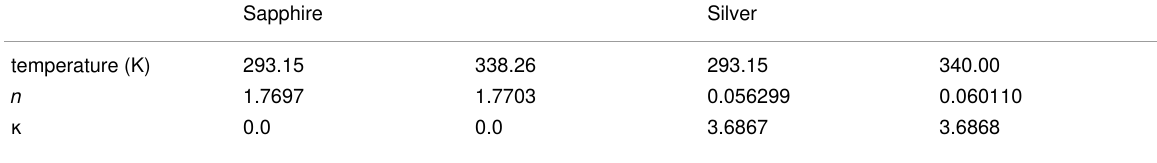
Table 1: Refractive indices for silver and sapphire at room temperature and at the highest temperature reached by the structure at time t = 1.68